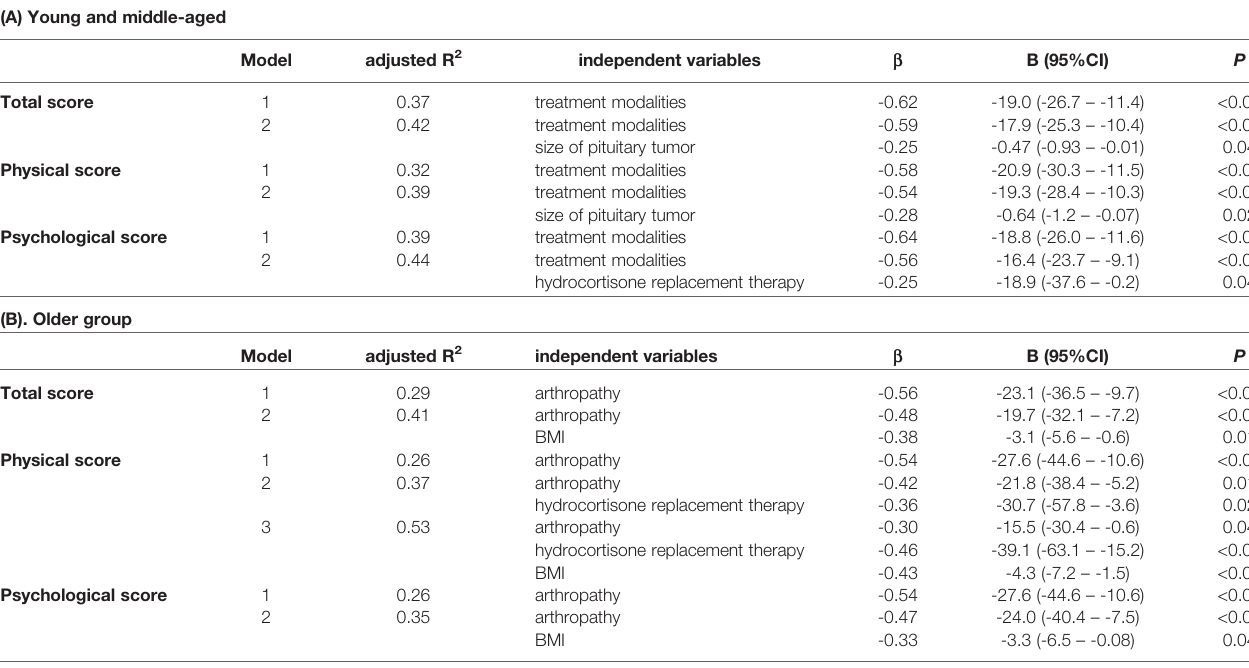
TABLE 4 | Multivariate regression analysis of determinants of AcroQoL score.